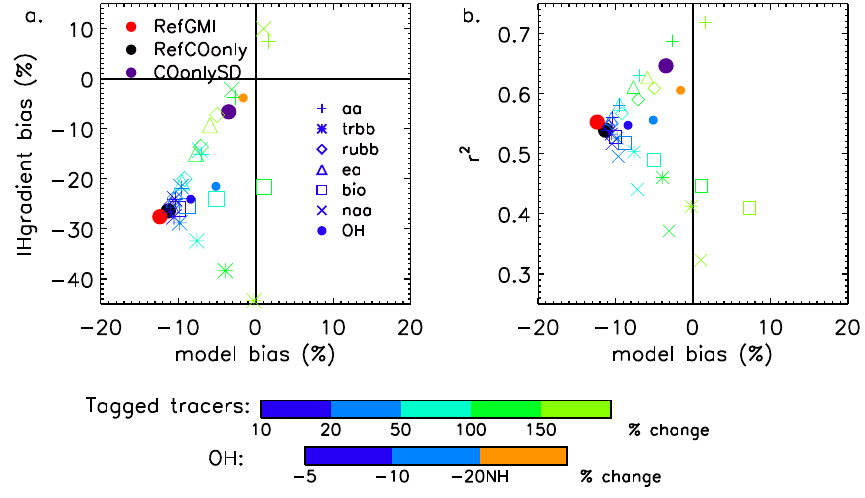
Figure 5. As in Fig. 4 but for June through